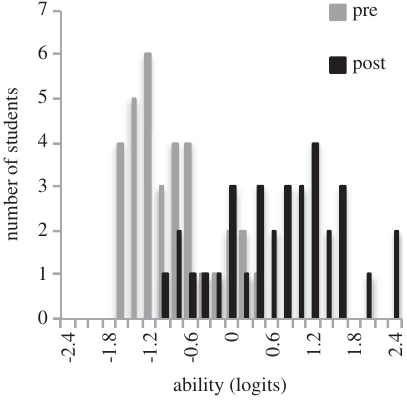
FIG. 18. The pre- and postability histogram for class 4.